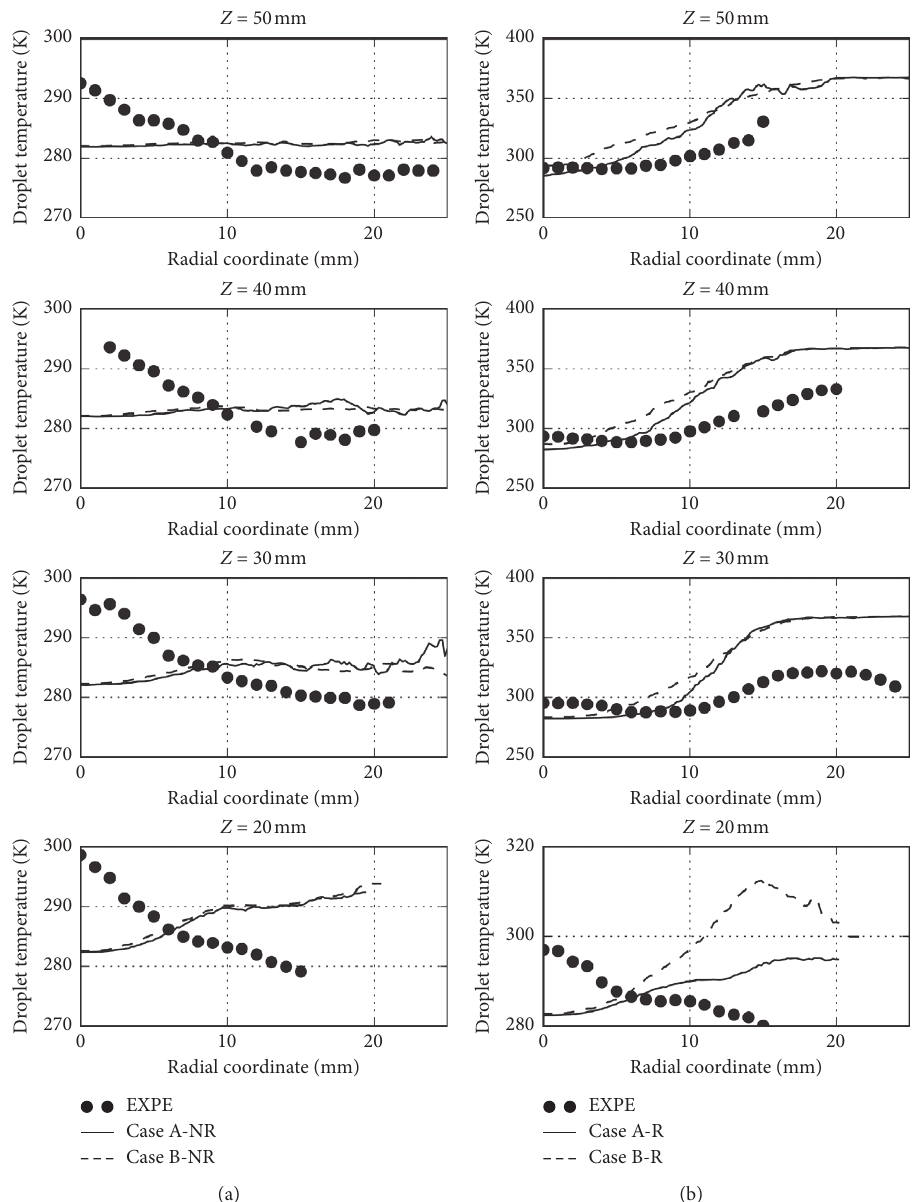
Figure 28: Radial profiles of droplet temperature for nonreacting (a) and reacting case (b). Symbols: experiments, solid line: case A dashed line: case